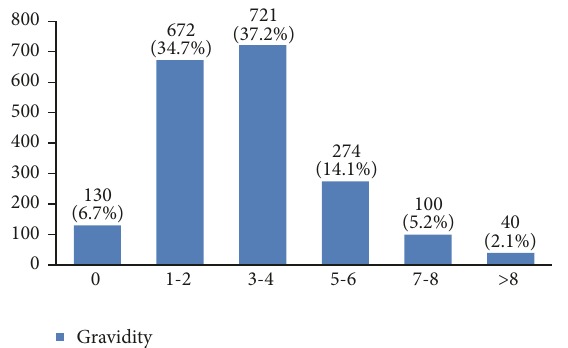
Figure 9: The breast feeding duration of the studied breast cancer cases.